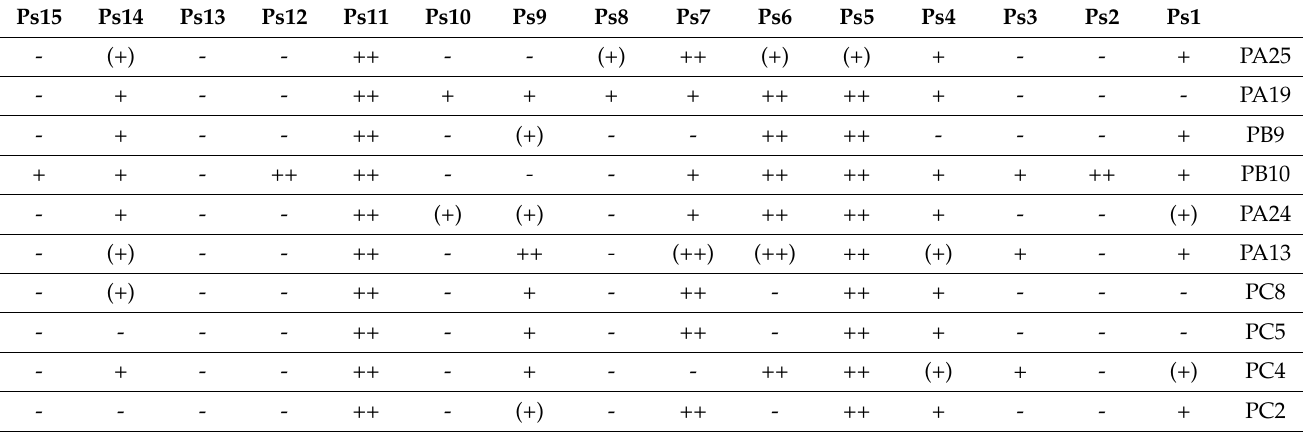
Table 1. Phage typing results on Pseudomonas aeruginosa .